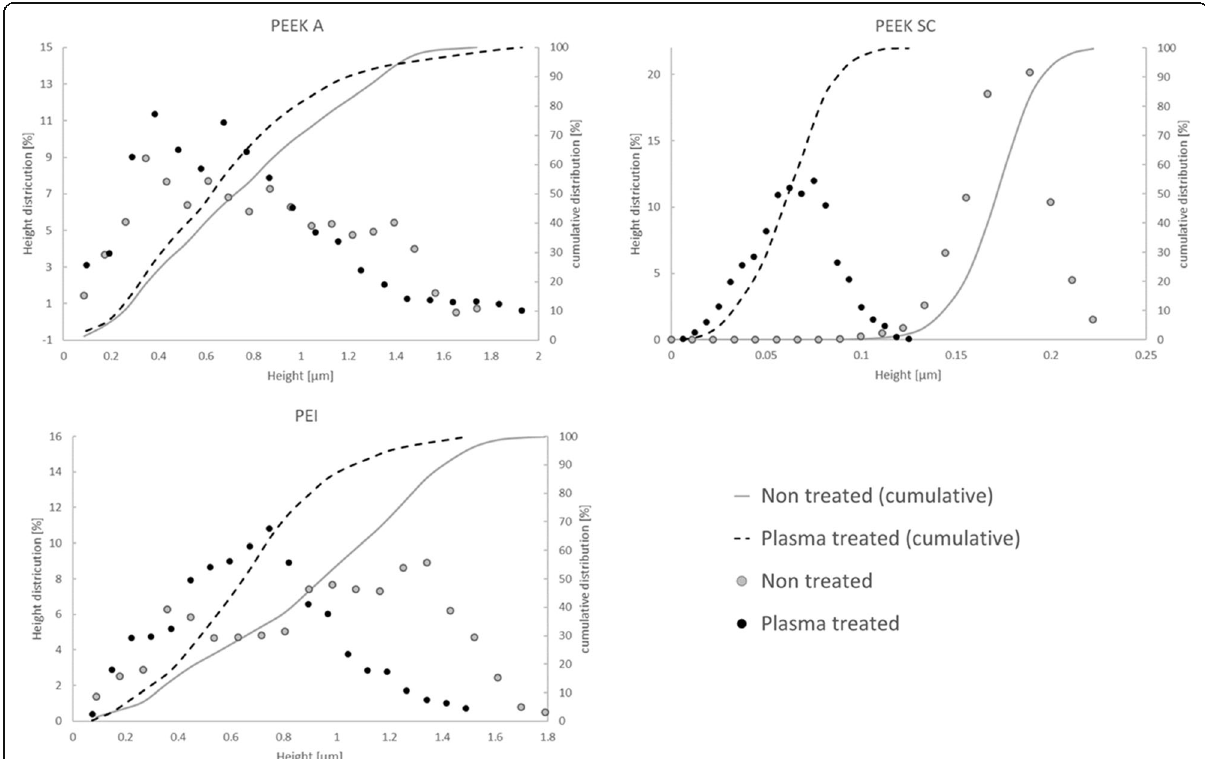
Fig. 7 Abbot-Firestone curves for PEEK A, PEEK AC and PEI before and after plasma